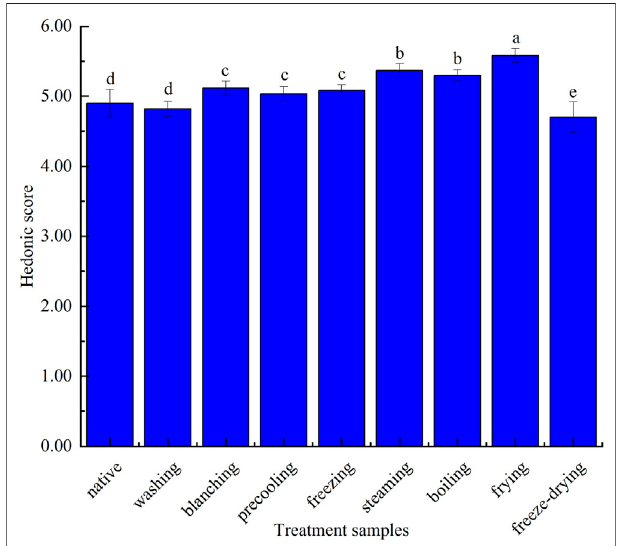
FIGURE 6 | Hedonic score of corn under nine kinds of different